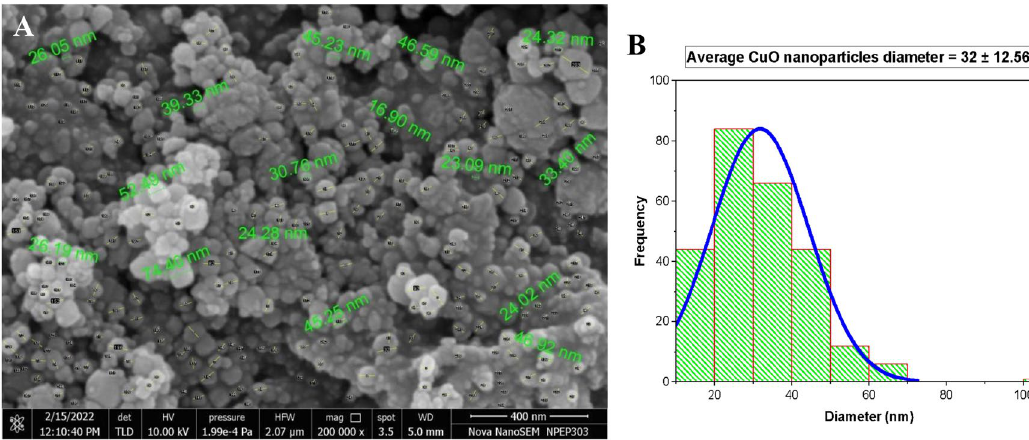
00.511.522.533.544.555.56